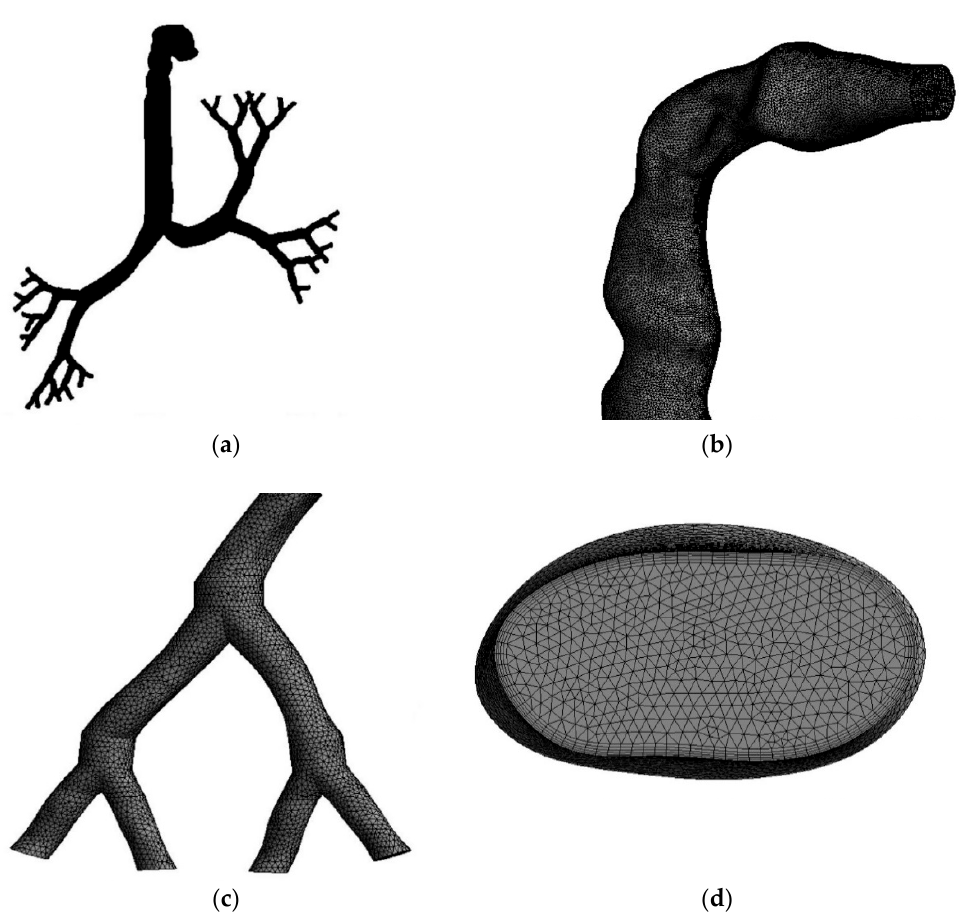
Figure 2. Unstructured mesh for selected sections of the airway model; ( a ) mesh for the whole lung model (cells invisible because of a large number of small cells), ( b ) tetrahedral elements for the mouth-throat section, ( c ) the mesh at a bifurcation branch, and ( d ) inflation mesh at the inlet cross-section of the mouth